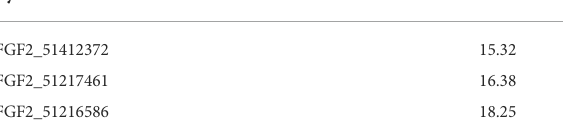
TABLE 2 Entropy energy of the studied